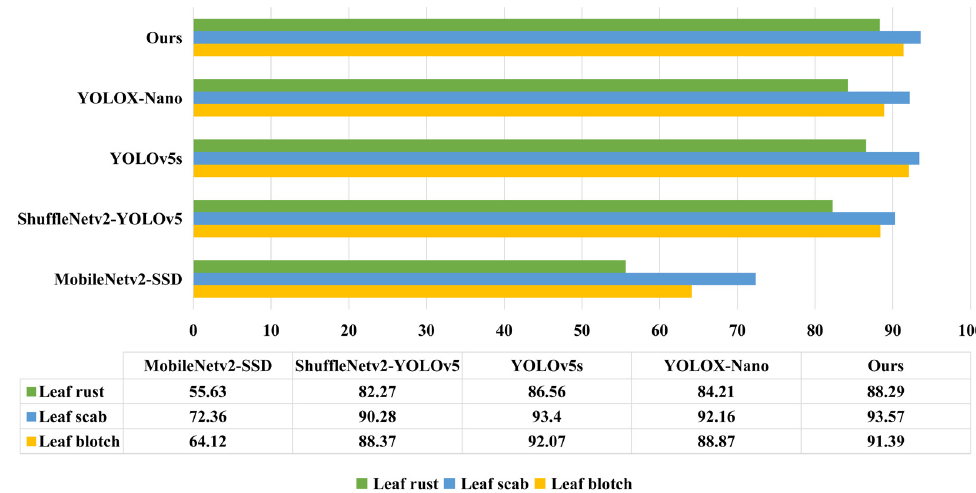
Figure 7. Average precision (AP) for the three disease categories of MSALDD.